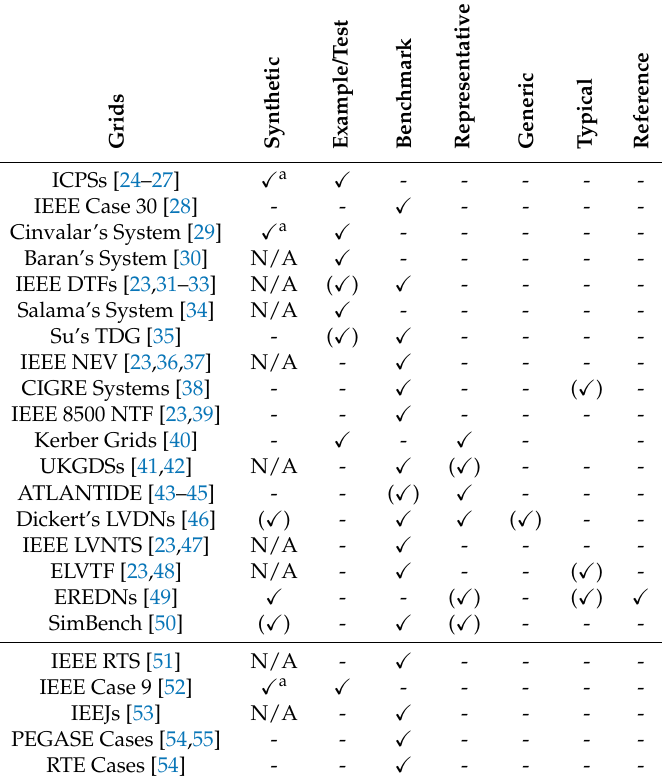
Table 4. Application of the recommended terminology to the well-known grids: well-suited terms ( (cid:88) ), partially fitting terms (( (cid:88) )), inappropriate terms (-), missing information